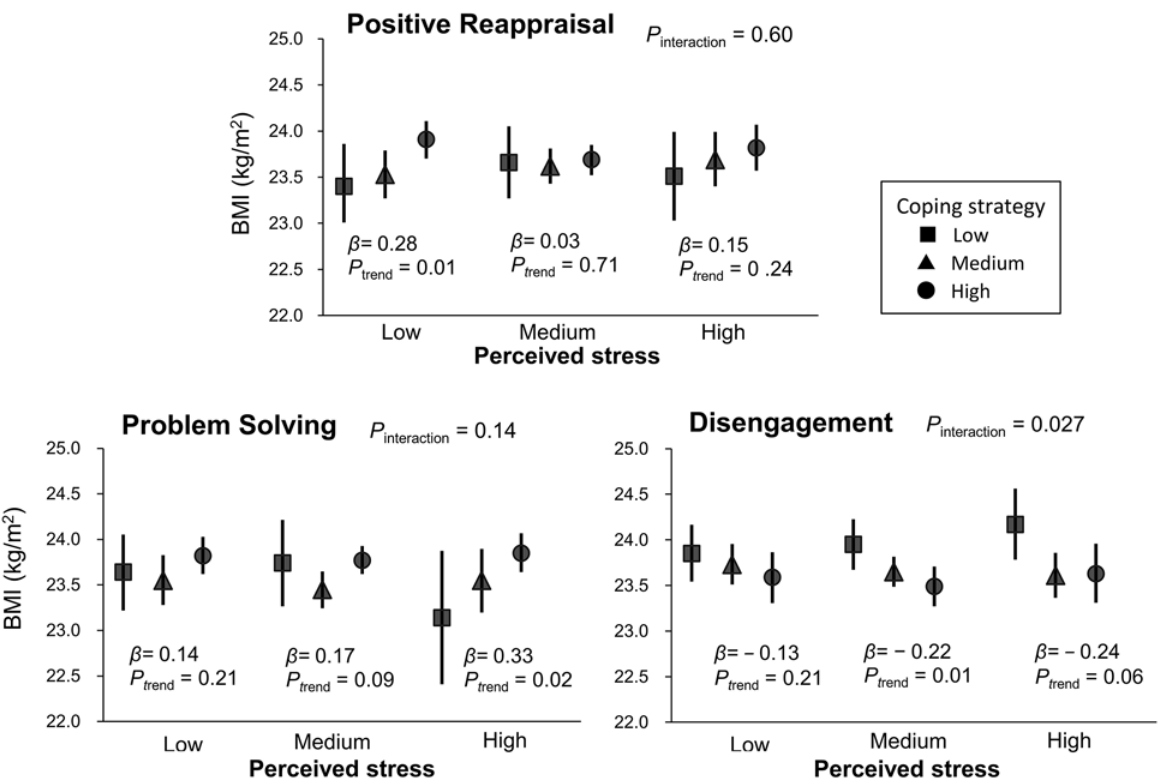
Fig 1. Adjusted means of body mass index (BMI) by levels of selected coping strategies and by perceived stress levels in men. β represent regression coefficients in kg/m 2 . Adjustment was made for age, socio-economic status (occupation, working hours, and years of schooling), and lifestyle factors (drinking, smoking, physical activity level, sleeping hours, and energy intake). P values for trend were estimated from multiple linear regression analysis including in the model an ordinal variable (1 – 3 assigned to low, medium, and high levels, respectively) for each coping strategy. Symbols show means and error bars represent 95% confidential